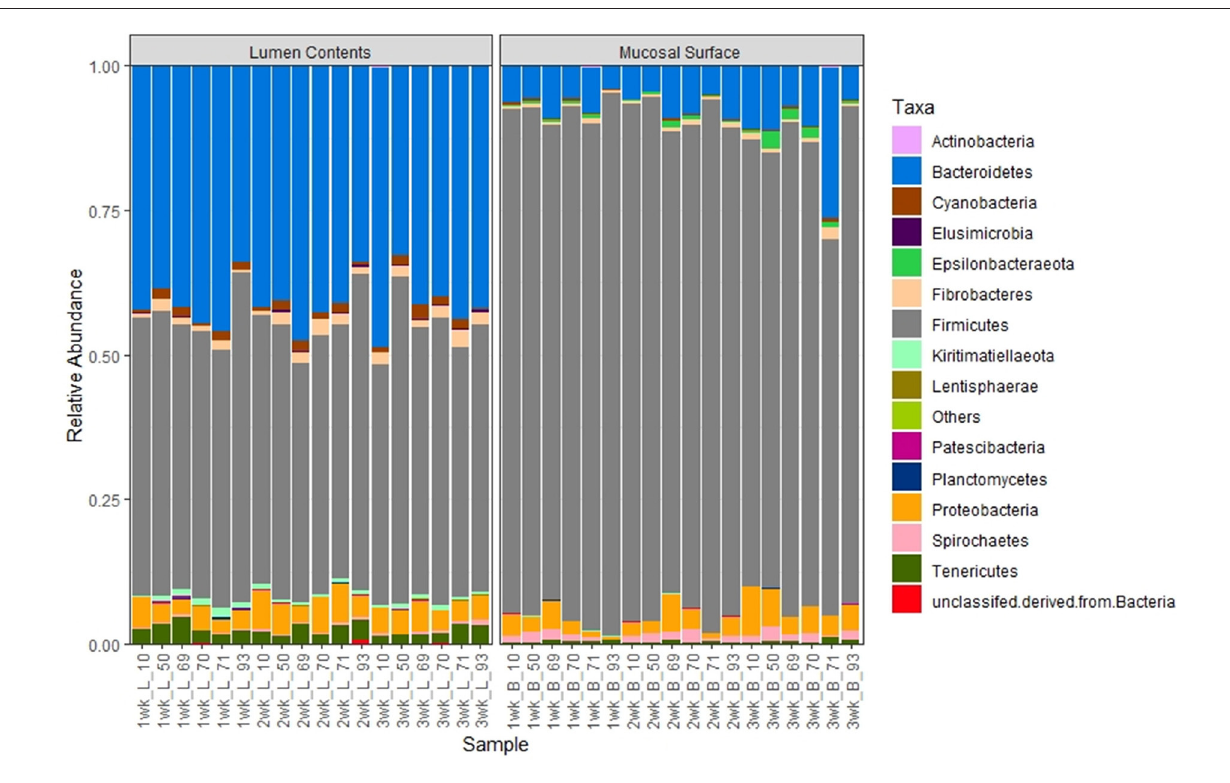
Frontiers in Veterinary Science |